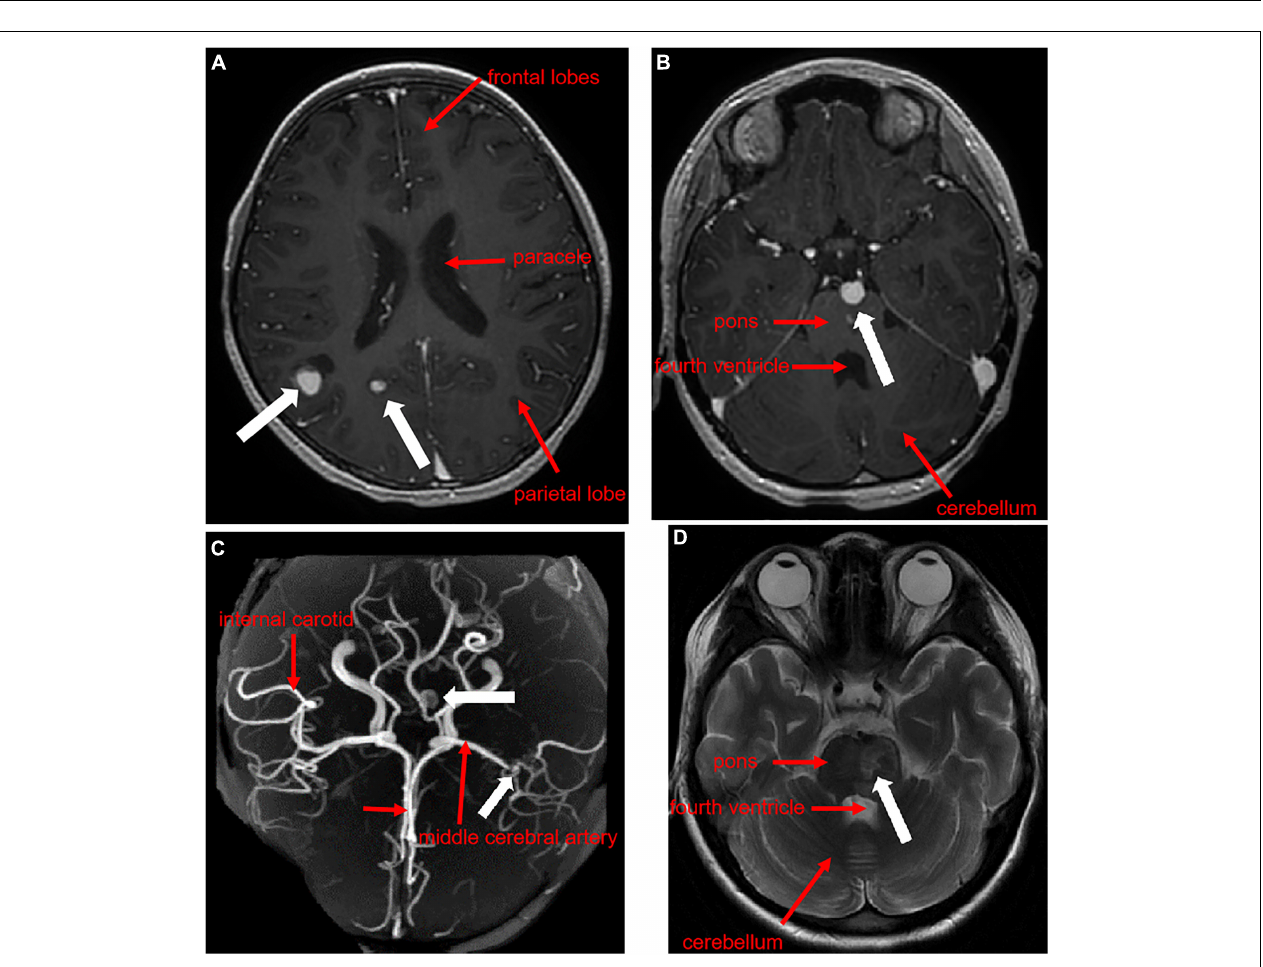
FIGURE 3 | Contrast-enhanced cranial MRI + MRA of the pediatric patient. The transverse plane through the inferior portion of the parieto-occipital sulcus showed a distal aneurysm of the right middle temporal artery and the right posterior cerebral artery (A) , the transverse plane through the superior cerebellar peduncle showed an aneurysm at the tip of the basilar artery and stenosis of the left middle cerebral artery with multiple collateral vessel formation (B,C) , and the transverse plane through the superior cerebellar peduncle showed an abdominal cerebral infarction (D) .